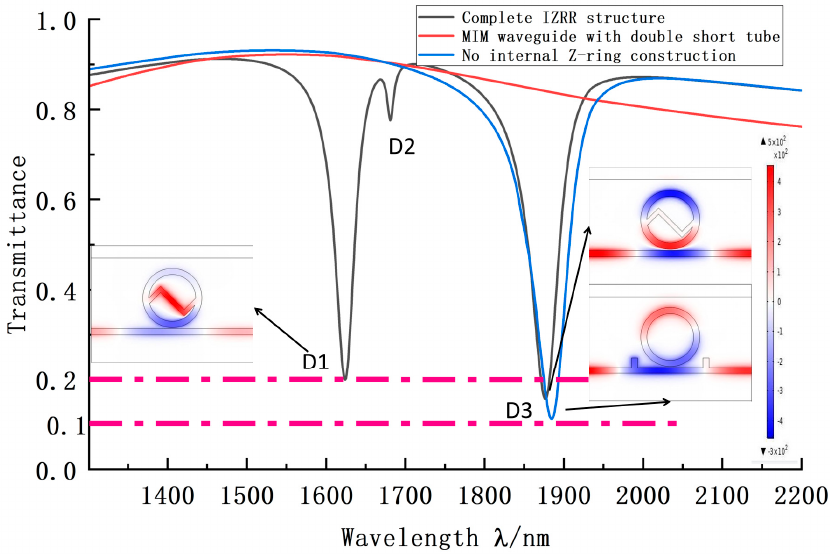
Figure 2. Transmission curves of complete IZZR structure (black curve), ring structure without internal Z-structure (blue curve), and MIM waveguide structure with a short double tube (red curve). The illustration is a normalized map of the magnetic field intensity distribution.